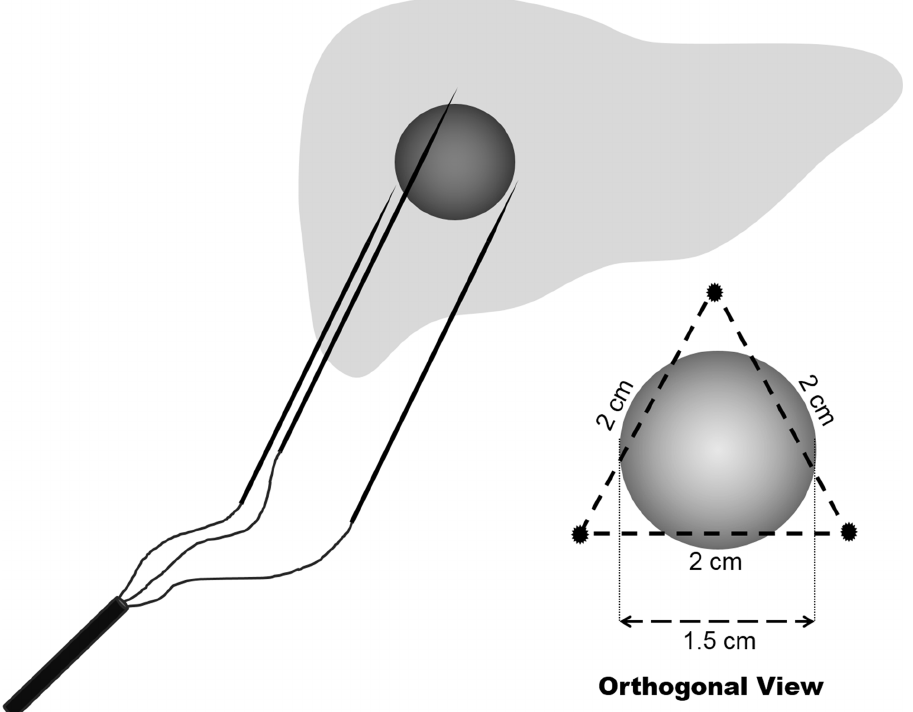
Fig 3. Photographs of a separable cluster electrode (Octopus 1 , STARmed) composed of three internally- cooled electrodes that can be incorporated as (A) one cluster electrode with a large shaft, or separated as (B) three individual applicators with small